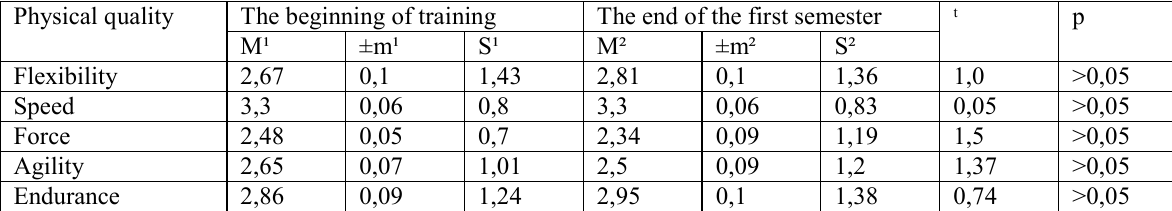
Test results of physical characteristics of students (in points) in physical rehabilitation groups (n = 197) during the 2010 - 2013 academic